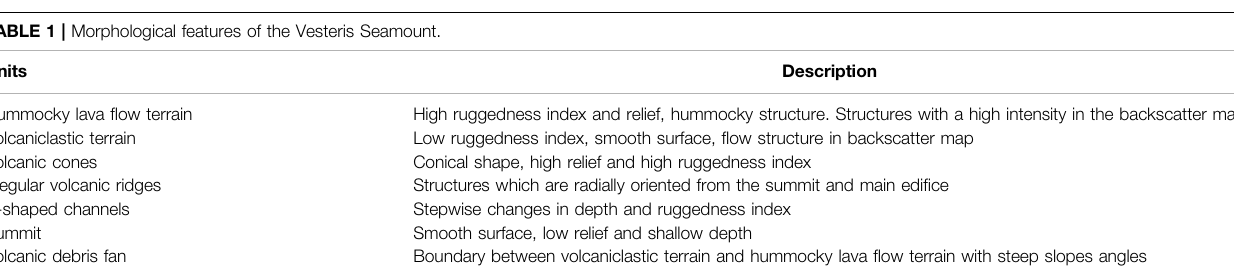
Hummocky lava fl ow